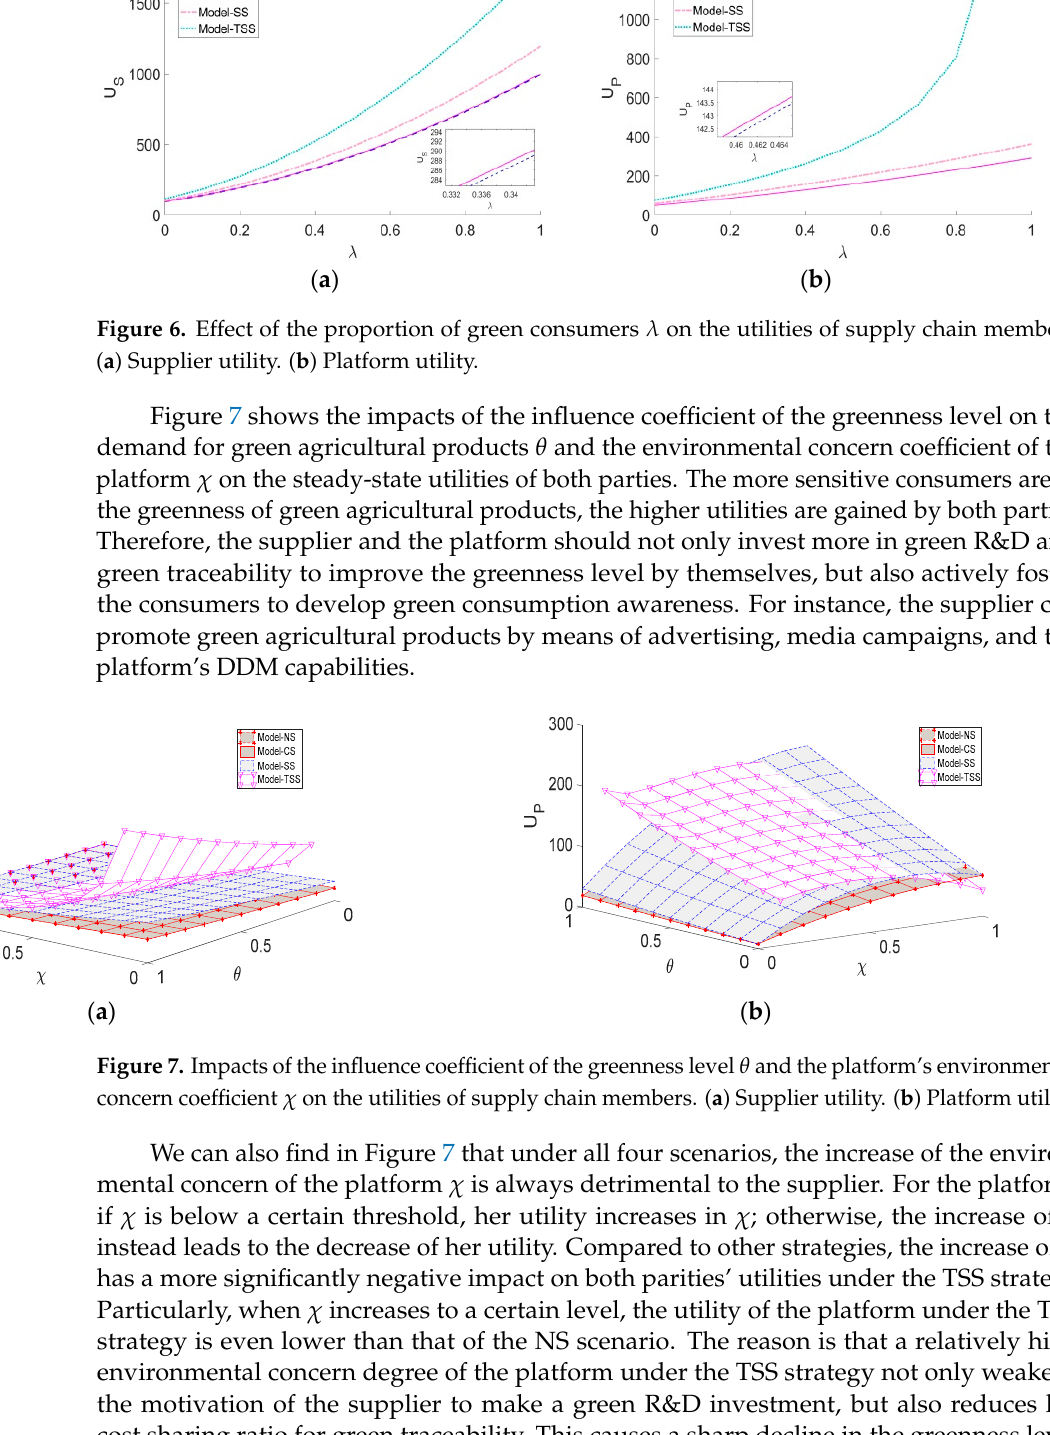
Figure 5. Effects of the government subsidy ratio on performances under different scenarios. ( a ) Market demand for two types of agricultural products. ( b ) Supplier utility. ( c ) Platform utility.